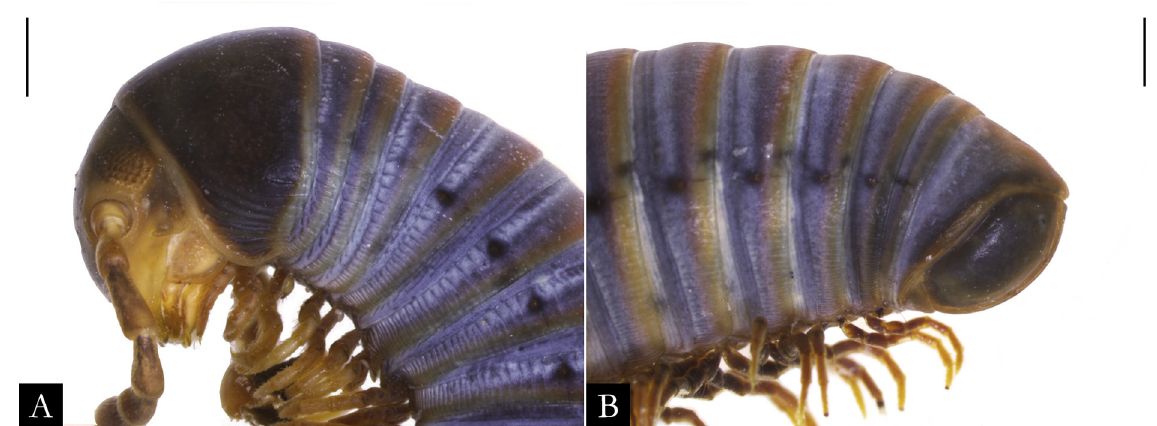
Fig. 56. Pseudonannolene caatinga Iniesta & Ferreira, 2014, ♂ (IBSP 2178), in lateral view. A . Anterior region. B . Posterior region. Scale bars = 1